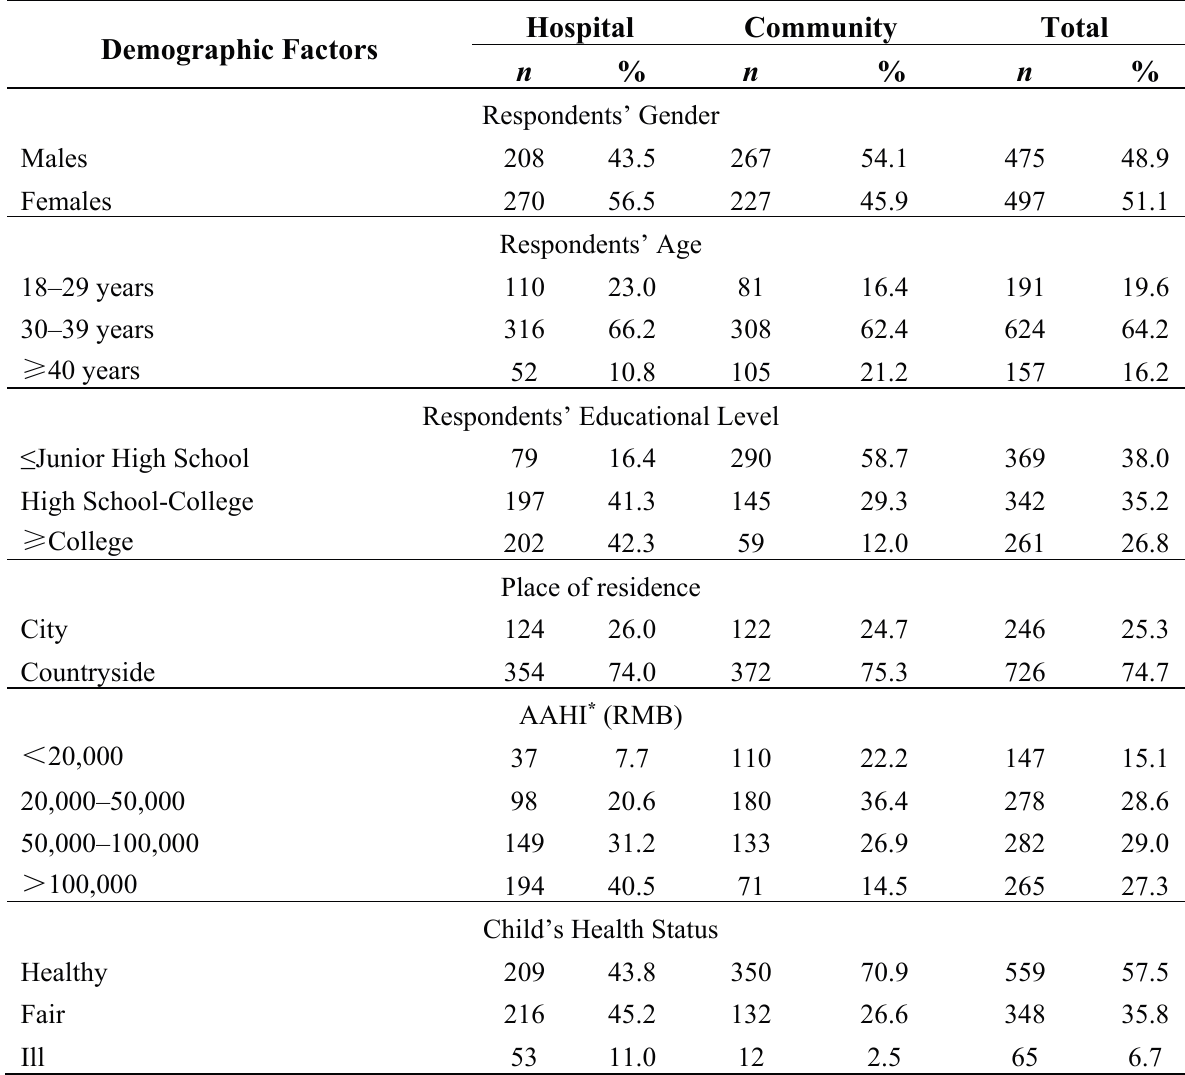
Table 1. General demographic information of the